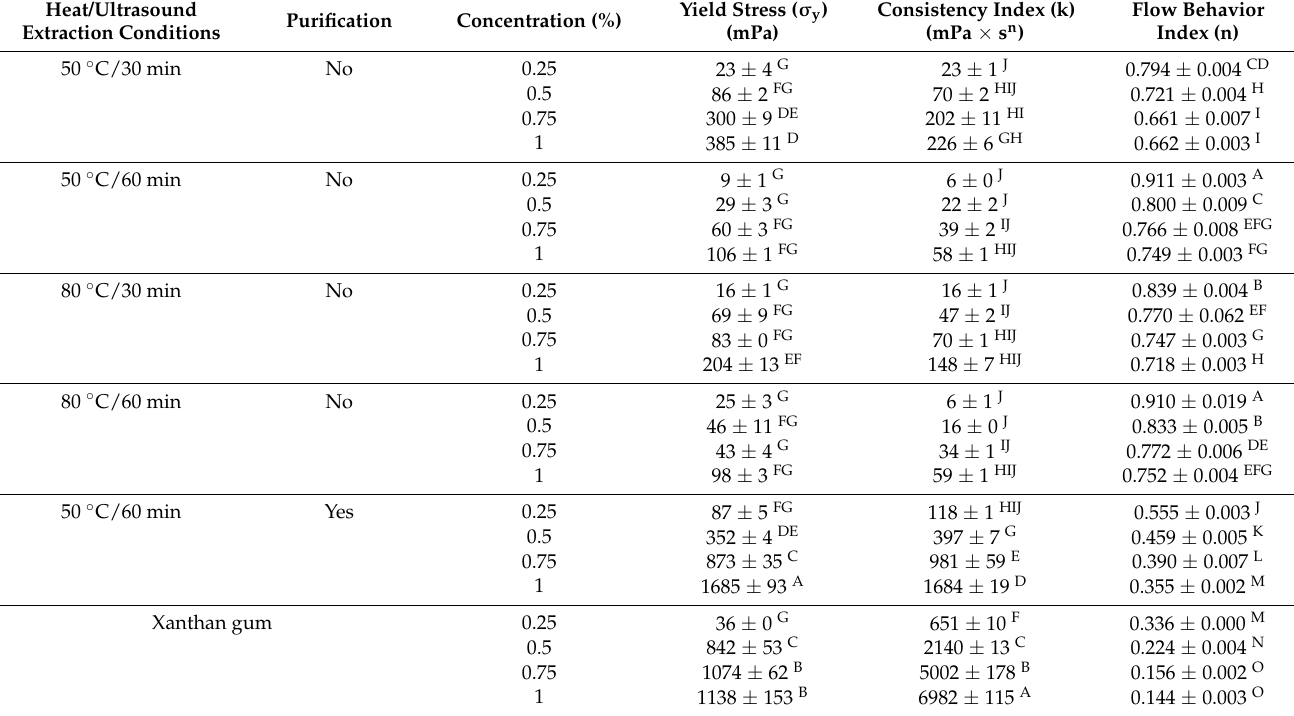
Table 4. Flow behavior of xanthan gum and chia seed mucilages extracted by ultrasound in combina- tion with